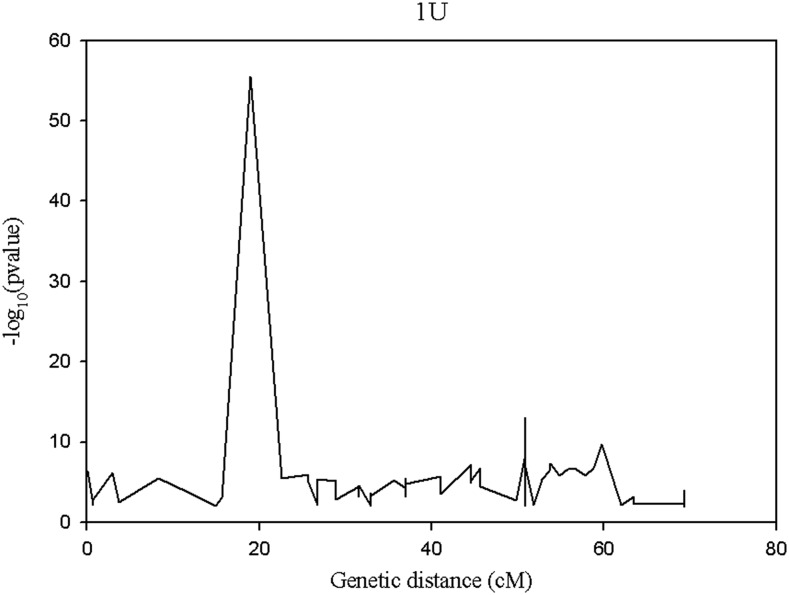
Pattern of segregation distortion across regions of chromosome 1 U. The y-axis indicates the segregation distortion p-value (in its negative logarithm form) for the corresponding genetic position on the x-axis.